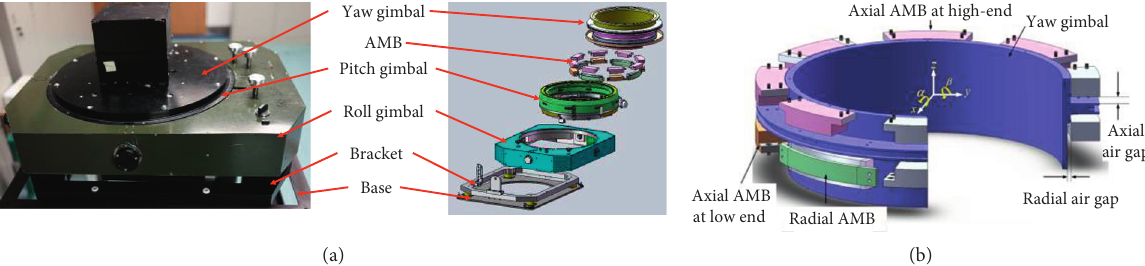
Figure 1: (a) Configuration of the three-axis ISP. (b) The structure of AMB system.